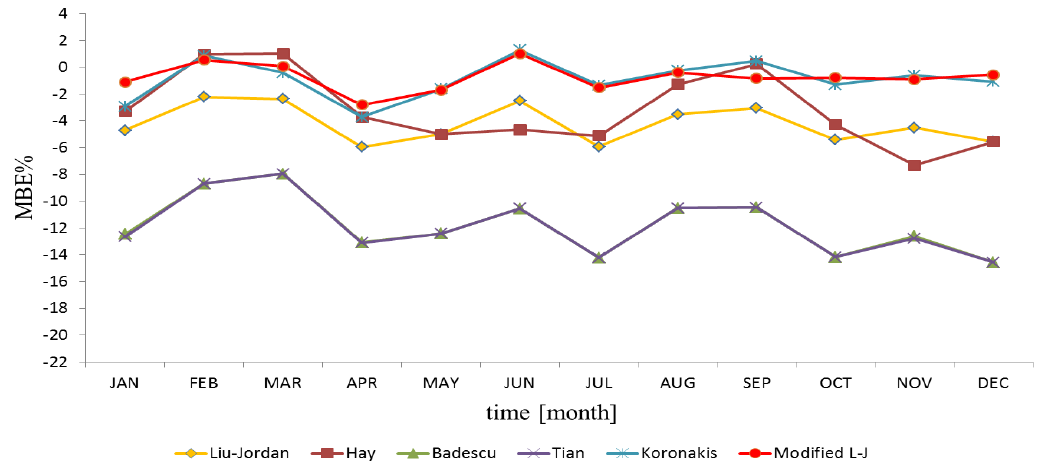
Figure 6. The differences in MBE% of incident solar radiation of multiple models for a plane facing south at an inclination angle of 45° located in Poznań,